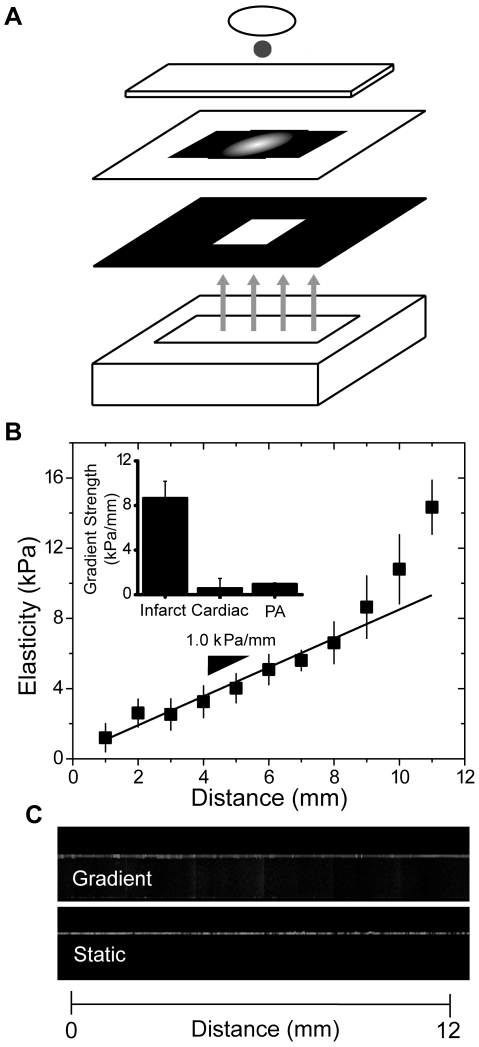
Hydrogel fabrication and characterization.(a) The schematic shows (from top to bottom) the 25 mm diameter aminosilanated glass coverslip, the acrylamide/bis-acrylamide solution with dissolved photoinitiator, a chlorosilanated glass slide, patterned photomask, negative photomask, and 254 nm UV light source. (b) AFM-determined elasticity of PA hydrogels was measured by every 1 mm from the center to the edge of the circular hydrogel. The gradient spans 10-fold change in elasticity from 1 to 14 kPa with a gradient strength of 0.96±0.12 kPa/mm. The inset shows a comparison of gradient strength of the hydrogel to those found in infarcted rat myocardium and the natural variations in adjacent, unaffected myocardium [15]. (c) Confocal microscopy images of collagen functionalized PA gradient (top) and static (bottom) hydrogels show collagen localized to the top surface of the hydrogels with roughly uniform distribution regardless of spatial changes in elasticity.